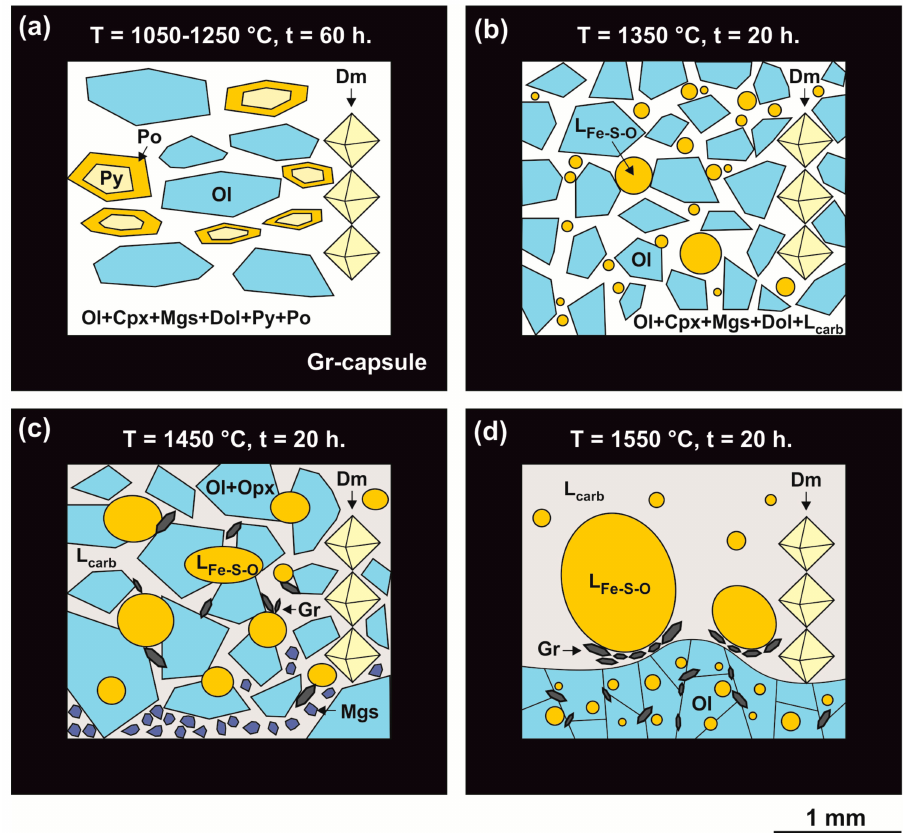
Figure 7. Schemes of samples produced in the olivine-ankerite-pyrite system at 6.3 GPa in a temperature range of 1050–1550 ◦ C; ( a ): T = 1050–1250 ◦ C; ( b ): T = 1350 ◦ C; ( c ): T = 1450 ◦ C; ( d ): T = 1550 ◦ C; Po—pyrrhotite, Py—pyrite, Dol—dolomite, Mgs—magnesite, Ol—olivine, Di—diopside, L carb-sil —carbonate-silicate melt, L Fe-S-O —sulfide melt with dissolved oxygen, Gr—graphite, Dm—diamond seed crystals.